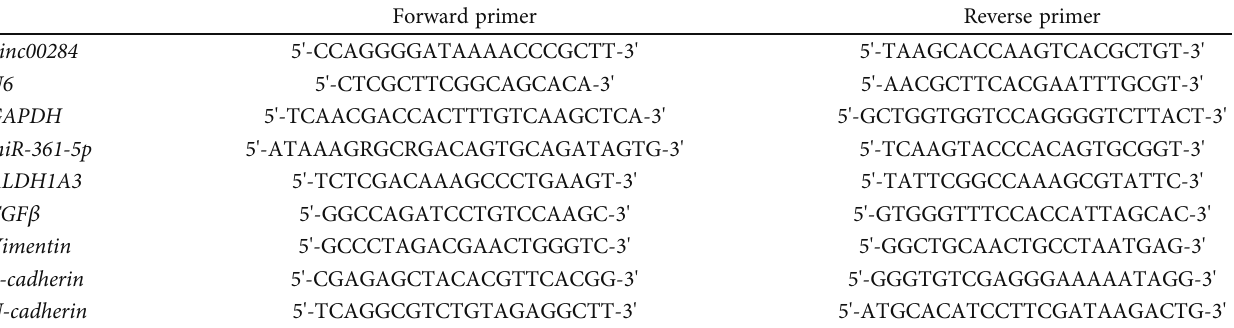
Table 1: Primer used in this